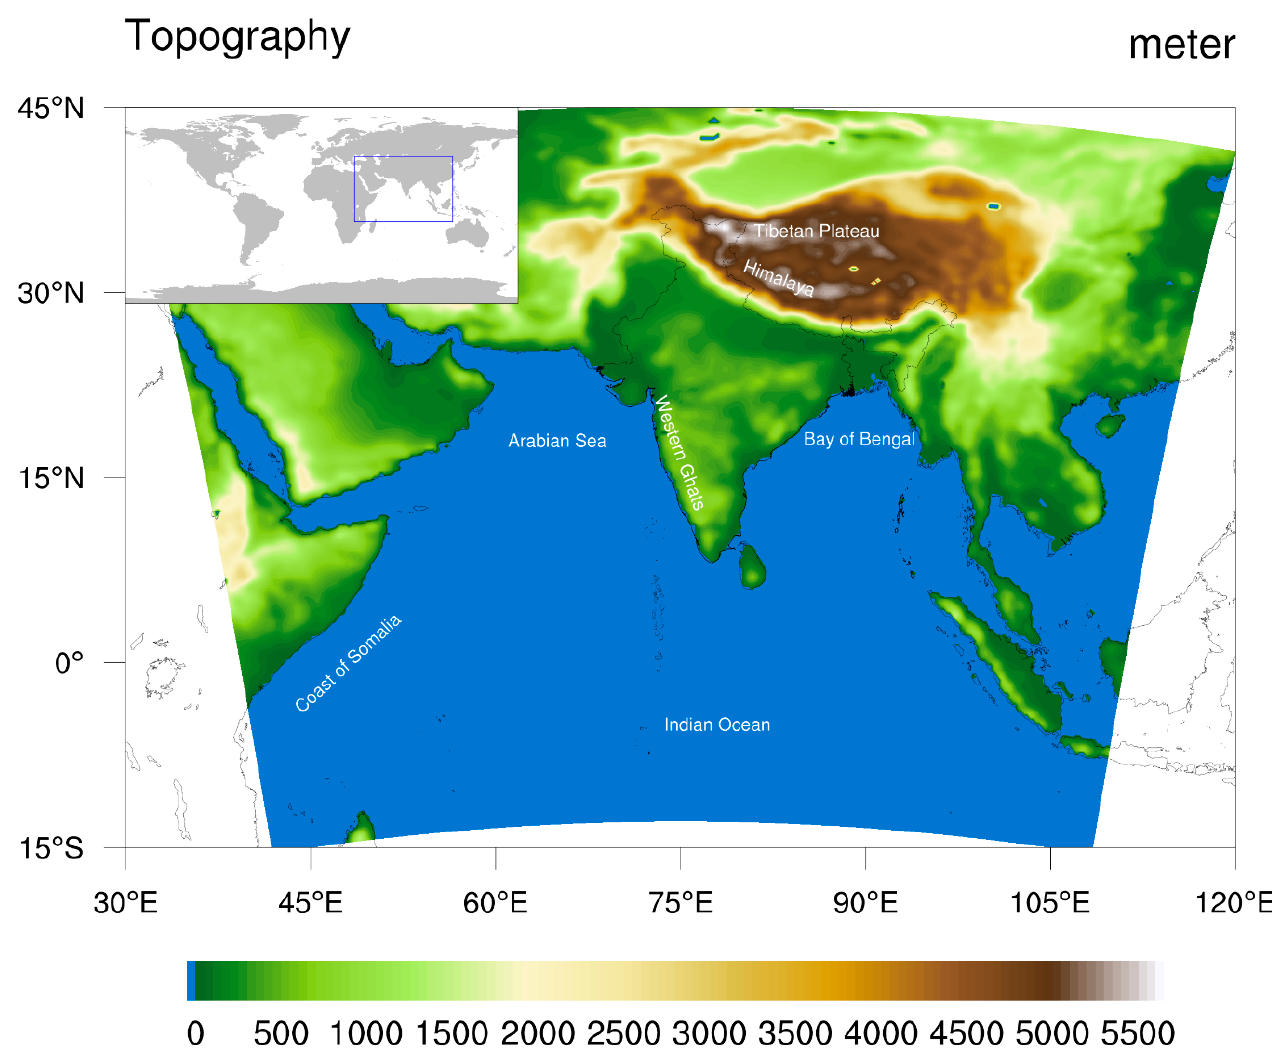
Figure 1. Map of the simulation domain used in the study. The domain encompasses 30° E–120° E, 15° S–45° N in Lambert Conformal map projection. Different color shades specify the topographical height above mean sea level (in meters). Table 1. Overview of the model considered for this study.